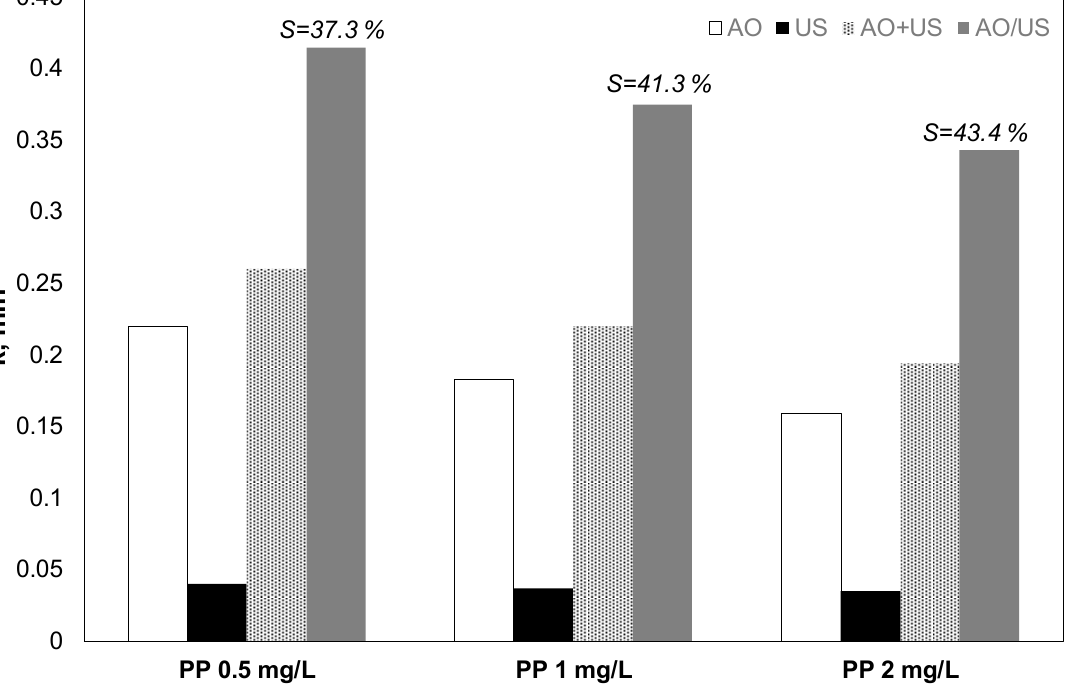
Figure 2. E ff ect of paraben initial concentration on the kinetic constant for the removal of propyl paraben by electrochemical anodic oxidation (AO), ultrasound (US), theoretical sum (AO + US) and combined (AO / US) process [Na 2 SO 4 ] = 0.1 M, 3.75 mA / cm 2 , 36 W / L at 20 kHz and inherent pH. Int. J. Environ. Res. Public Health 2020 , 17 , x